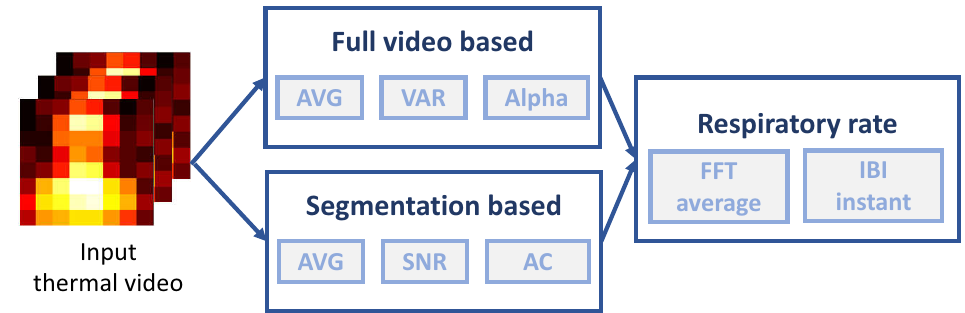
Figure 4. Overview of our algorithmic benchmark system. It consists of two image processing methods (full video based and segmentation based) for respiratory signal extraction and two methods for respiratory rate calculation. AVG—signal selection based on averaging; VAR—signal selection based on variation; Alpha—signal selection based on Alpha tuning; SNR—signal selection based on signal-to-noise ratio; AC—signal selection based standard